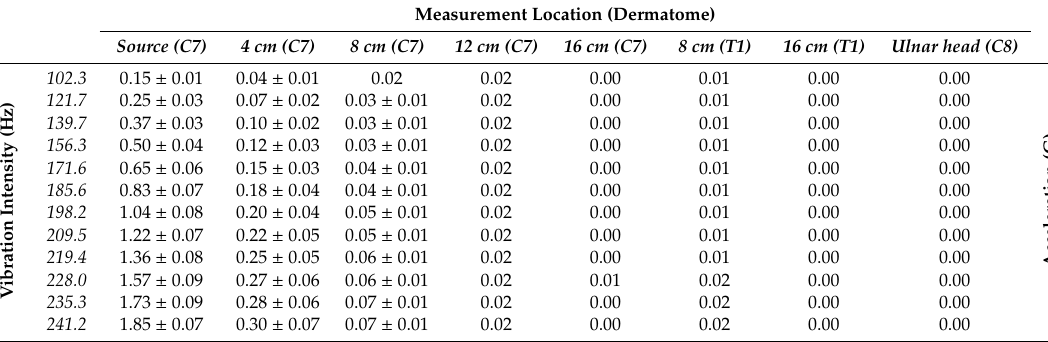
Table A3. Total acceleration (mean ± SEM) at each distance and test vibration intensity across six participants. Data without SEM indicate an SEM of <